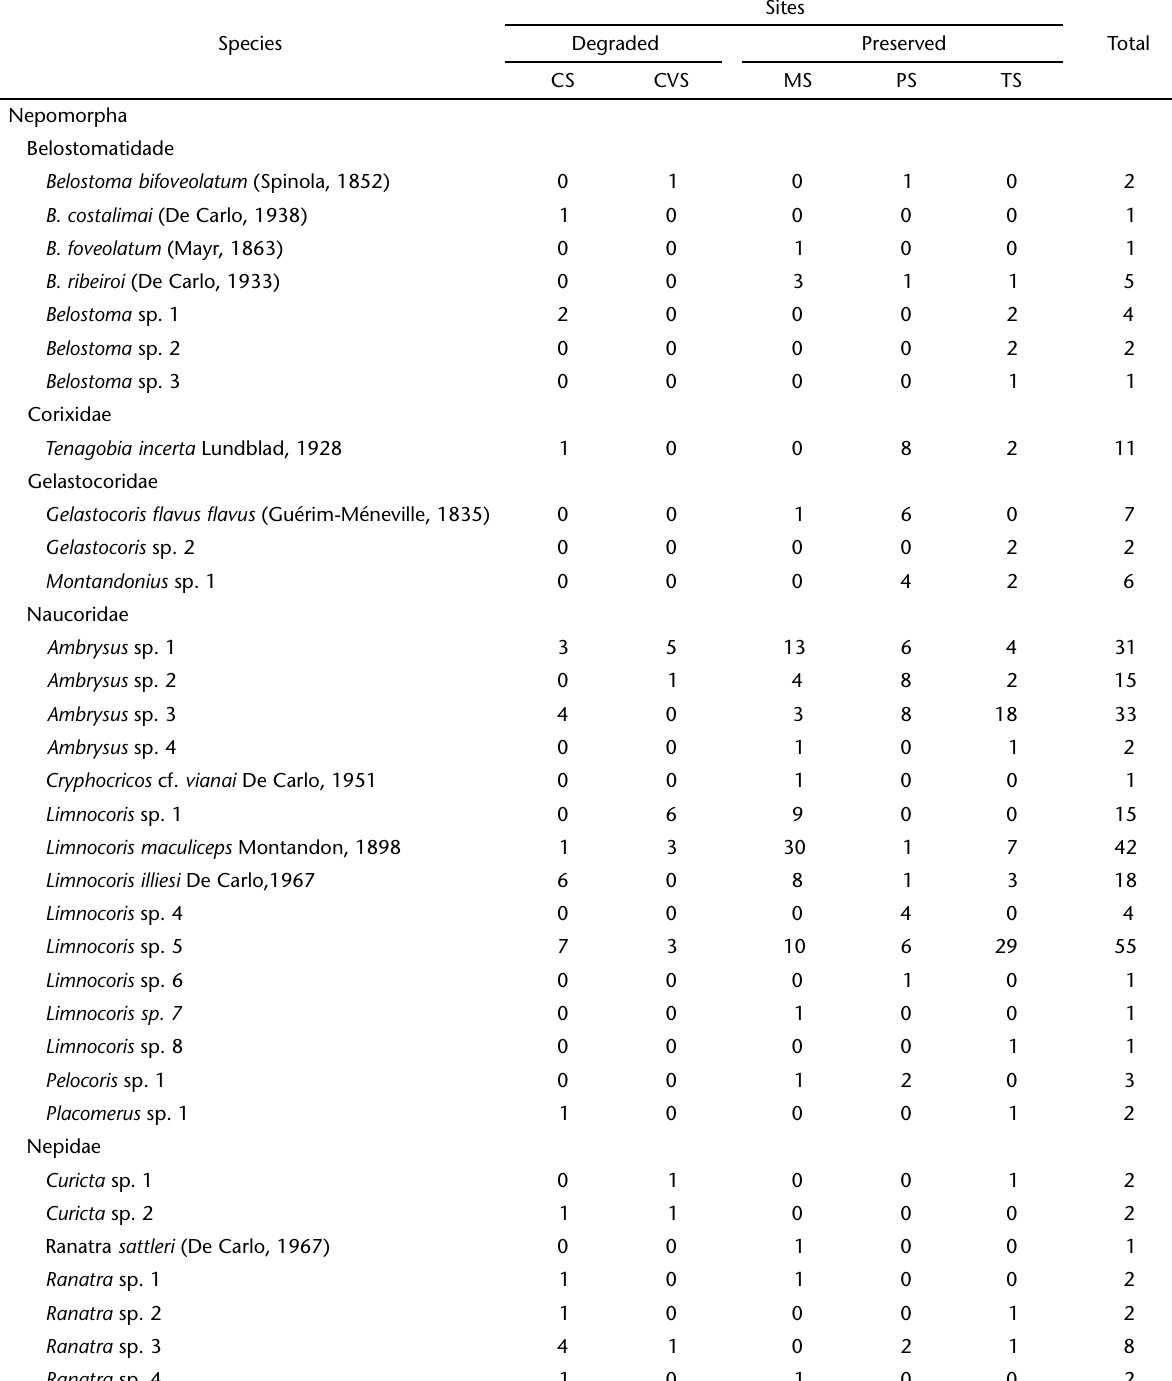
Table I. Nepomorpha and Gerromorpha abundance, based on samples carried out in the Pindaíba River Basin, Mato Grosso, 2008. (CS) Cachoeirinha Stream, (CVS) Caveira Stream, (MS) Da Mata Stream, (PS) Papagaio Stream, (TS) Taquaral Stream. Sites TotalDegraded Preserved Species CS CVS MS PS TS